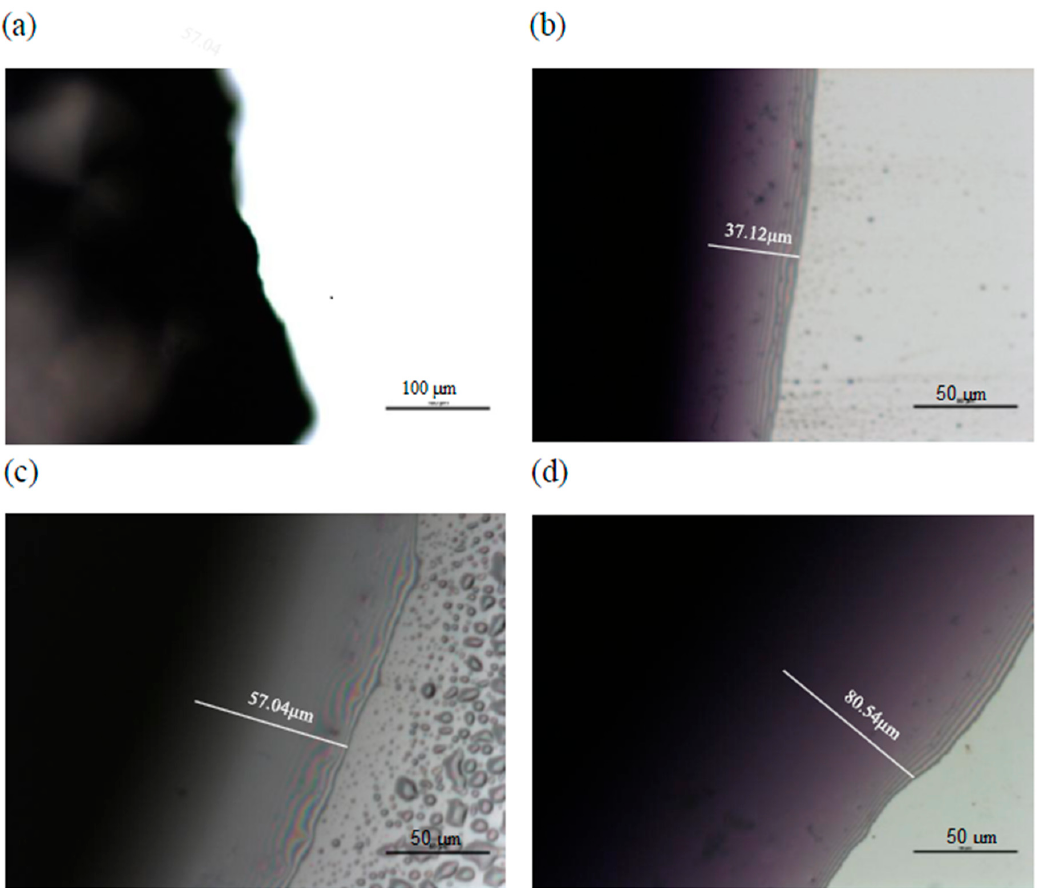
Figure 1. Micrograph of an apple (cross-section) coated with ( a ) control; ( b ) chitosan; ( c ) gelatin, and ( d ) chitosan–gelatin. The scale bar represents ( a ) 100 μ m and ( b – d ) 50 μ m.